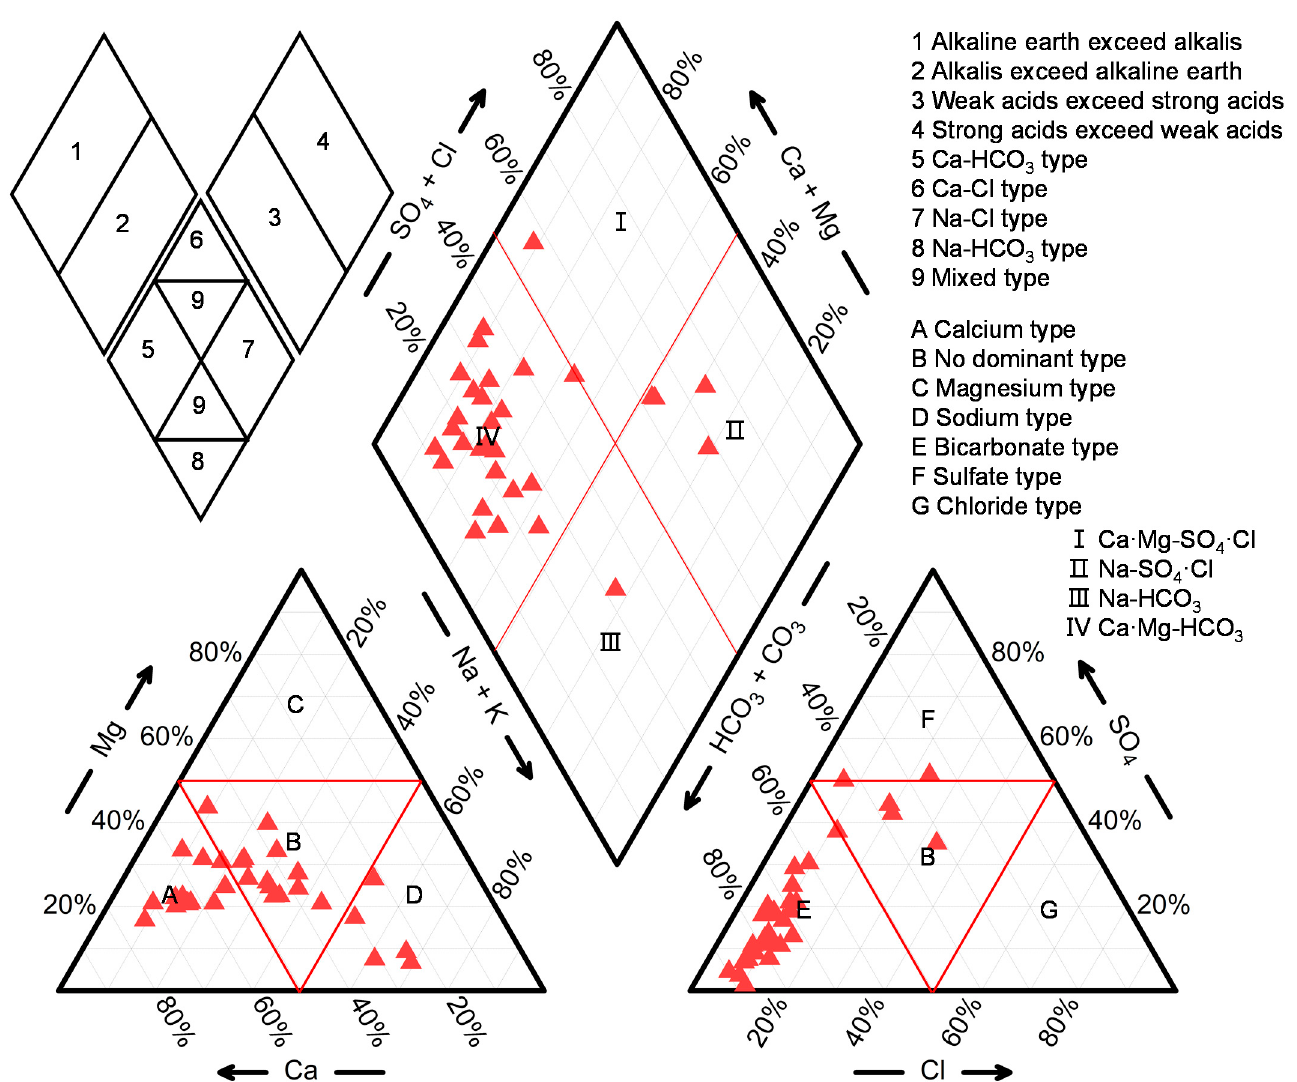
Figure 2. Piper diagram of the groundwater in the study area.